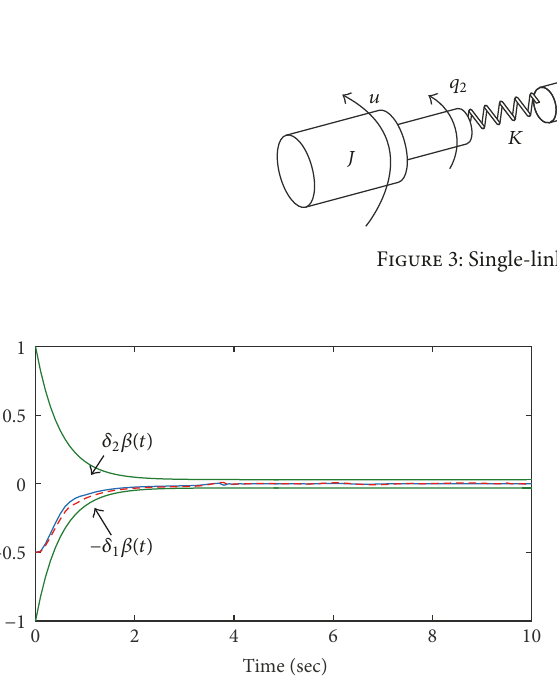
Figure 4: Tracking error: LC (-) and ANC (- -).